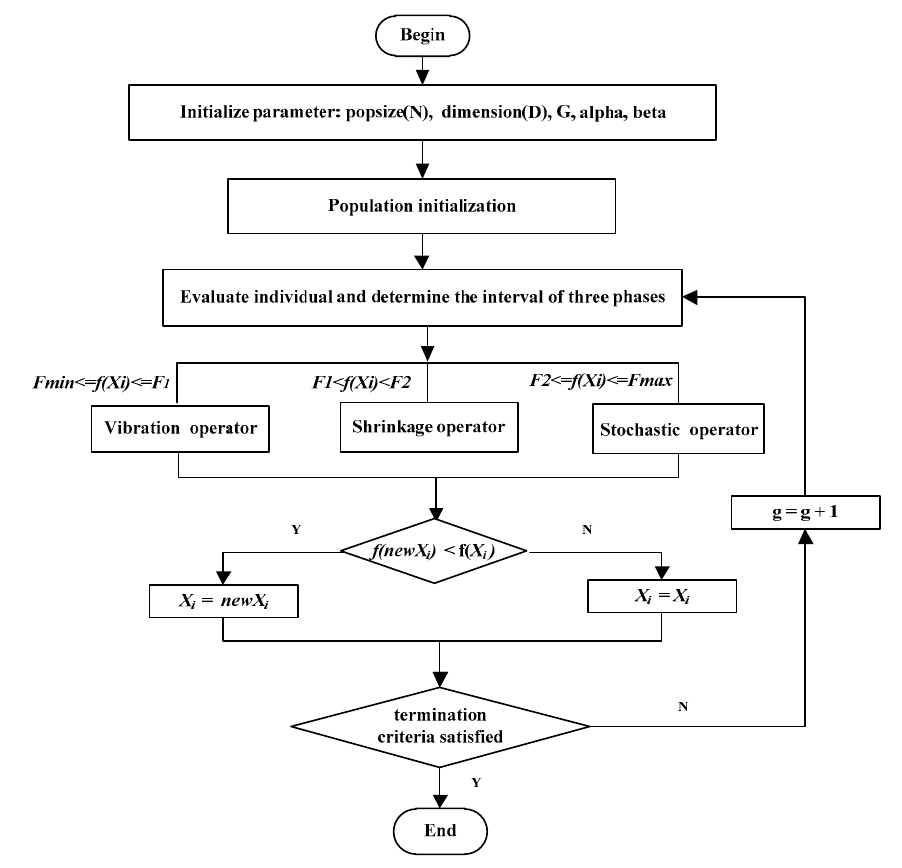
Figure 7. The main flowchart of PTBO.